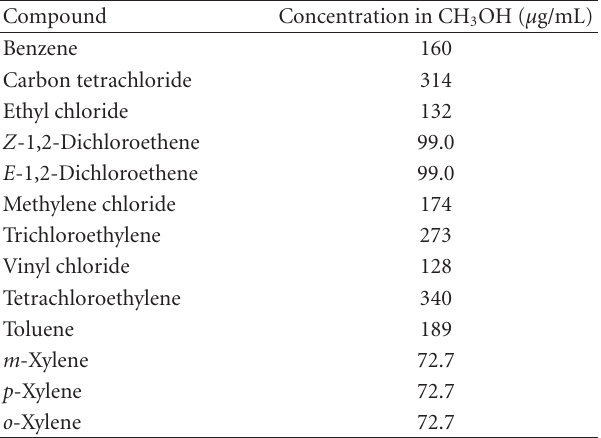
Figure 1: The HAPSITE Smart GC/MS system. Table 1: Composition of standard mix 1 used for construction of calibration